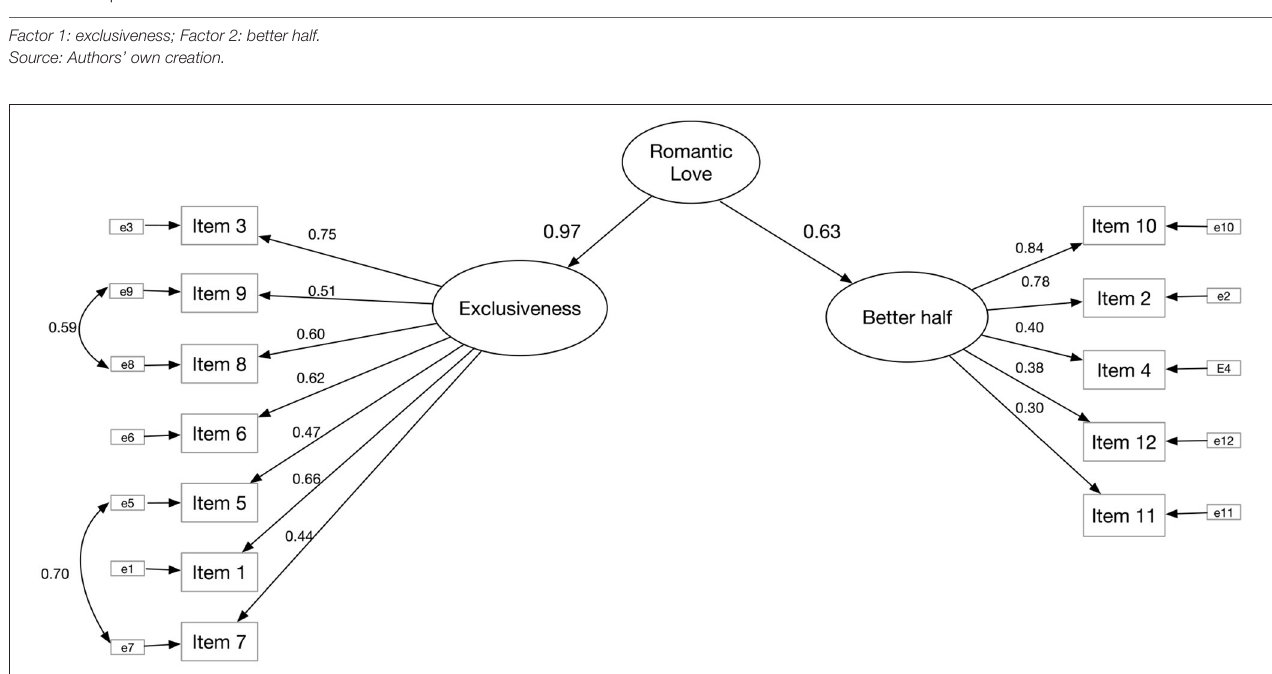
FIGURE 1 | Proposed CFA structure and factor loads. Source: Authors’ own creation.